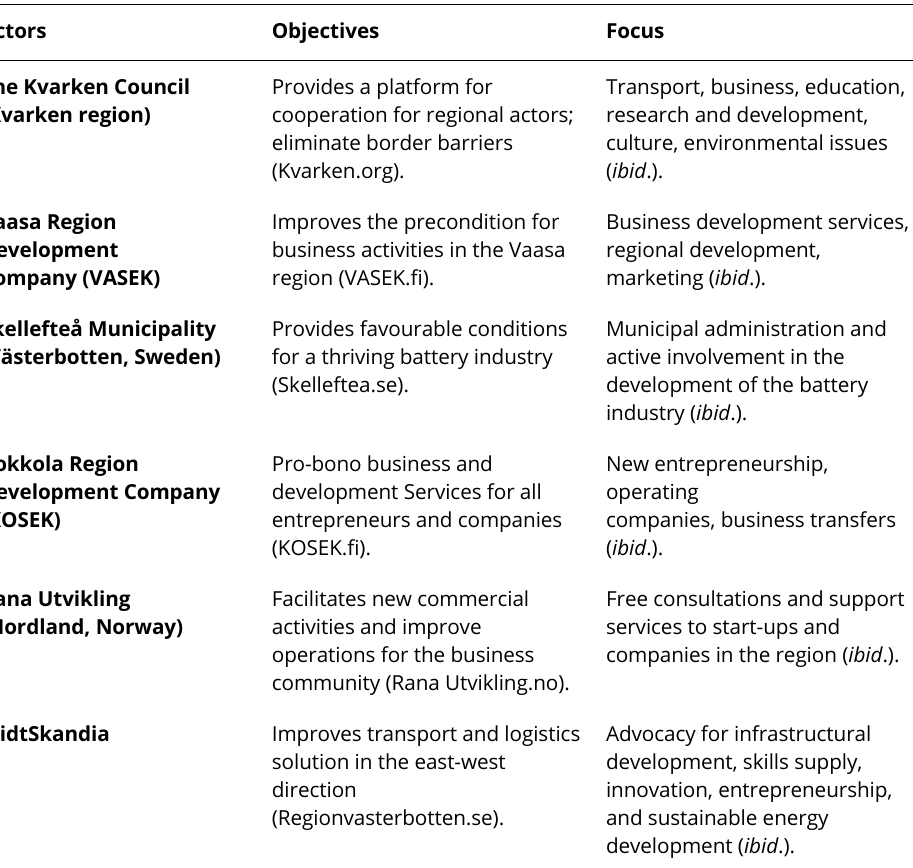
Table 1. Regional actors within the Nordic Battery